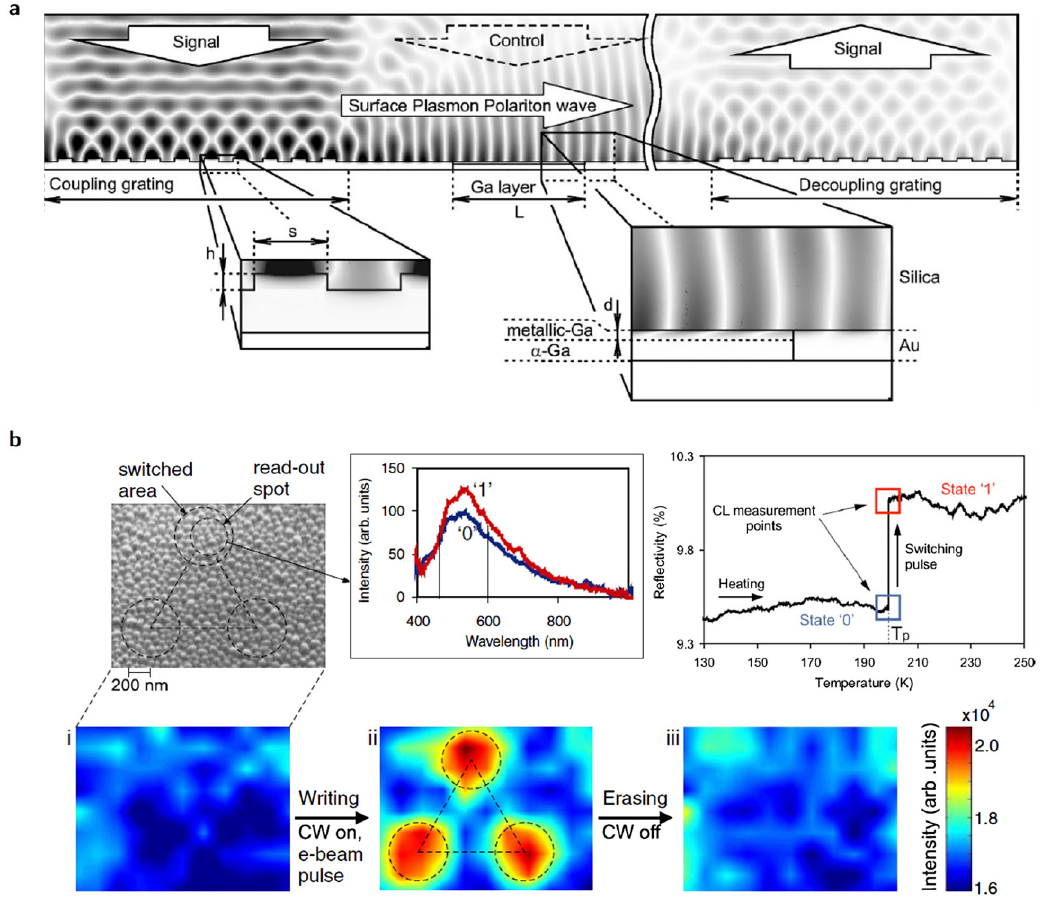
Figure 2: (a) Gold-on-silica surface plasmon polaritons (SPPs) waveguide containing a gallium section used a switch element to control the transmission of the waveguide. Field mapping shows the magnitude of the z component of the magnetic fi eld. Rearranged from the study by Krasavin and Zheludev [5]. (b) Gallium particle fi lm re fl ectivity as a function of increasing temperature, showing abrupt excitation-induced phase memory – state switching at T = 200 K. Cathodoluminescence measurements were made immediately before and after the induced transition. Rearranged from the studies by Denisyuk et al. [47,